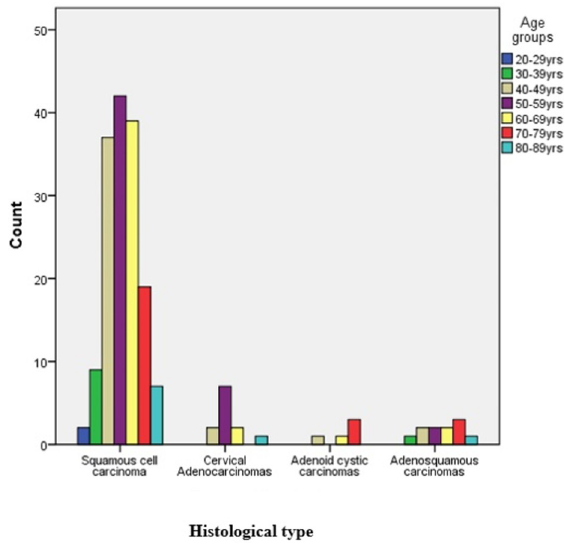
Fig 1. Clustered bar chart showing age group and the histological types of cervical carcinoma.